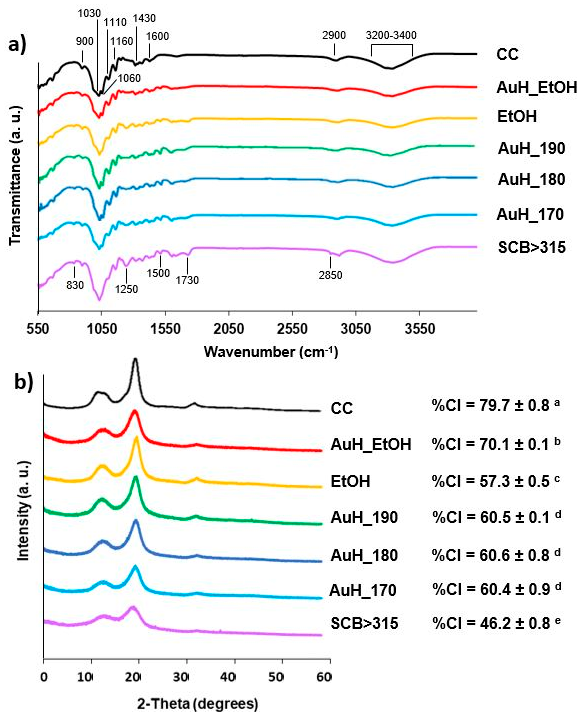
Figure 3. Structural characterization by ( a ) Fourier transform infrared spectrometry and ( b ) powder X-ray diffraction analysis of untreated sugarcane bagasse fraction superior to 315 µ m (SCB > 315), and fractions extracted by: auto-hydrolysis followed by organosolv with ethanol (AuH_EtOH); organosolv with ethanol (EtOH); auto-hydrolysis at 190 ◦ C (AuH_190); auto-hydrolysis at 180 ◦ C (AuH_180); and auto-hydrolysis at 170 ◦ C (AuH_170), in comparison with commercial cellulose (CC) used as control. CI averages followed by the same letters do not differ statistically by Tukey’s test ( p <